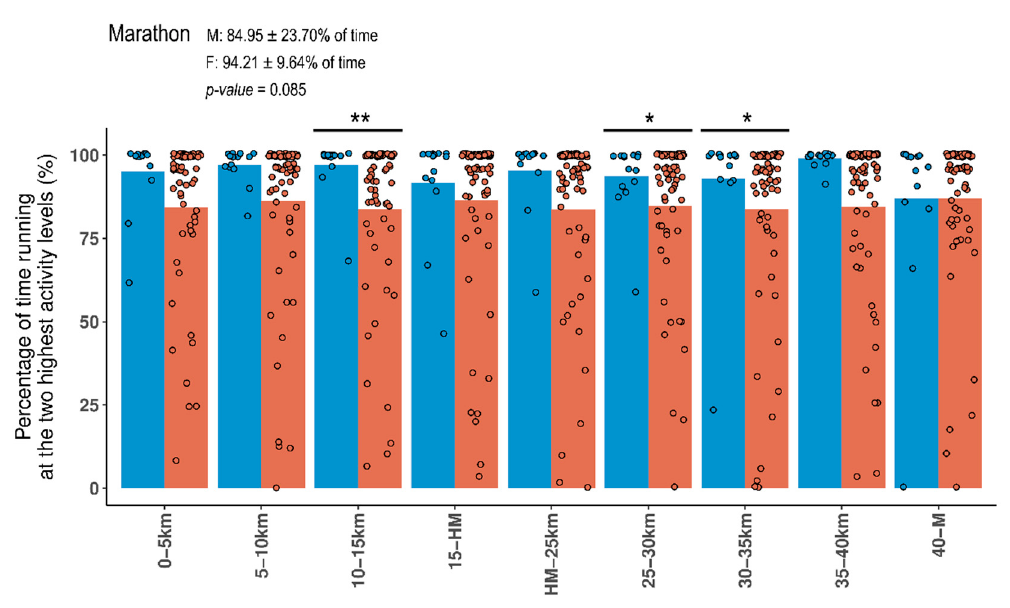
Figure 2. Bar plot showing the percentage of time performing at the two highest intensity levels of physical activity. Bars represent the average values for males (orange) and females (blue). Dots represent each runner included in our study. Mean percentage ( ± standard deviation) of time performing at these intensity levels is showed in the corresponding panel. A Mann–Whitney U test was used for testing differences between females (F) and males (M). * p -value < 0.05; ** p -value < 0.01.